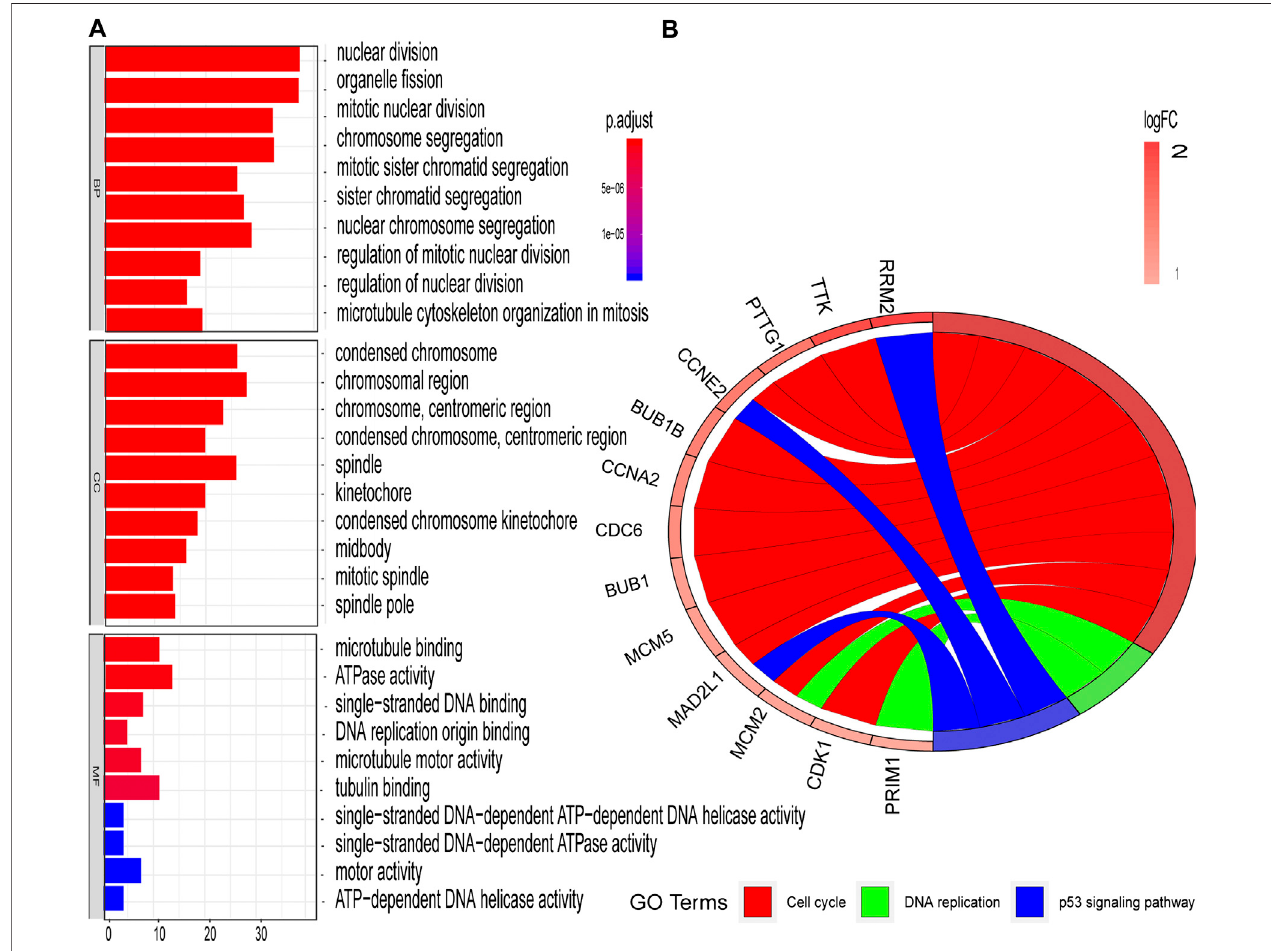
FIGURE 5 | GO and KEGG enrichment analyses of red modules (A) Enriched GO terms in Biological processes (BP), Cellular components (CC), and Molecular functions (MF) (B) Signi fi cantly enriched KEGG pathways.